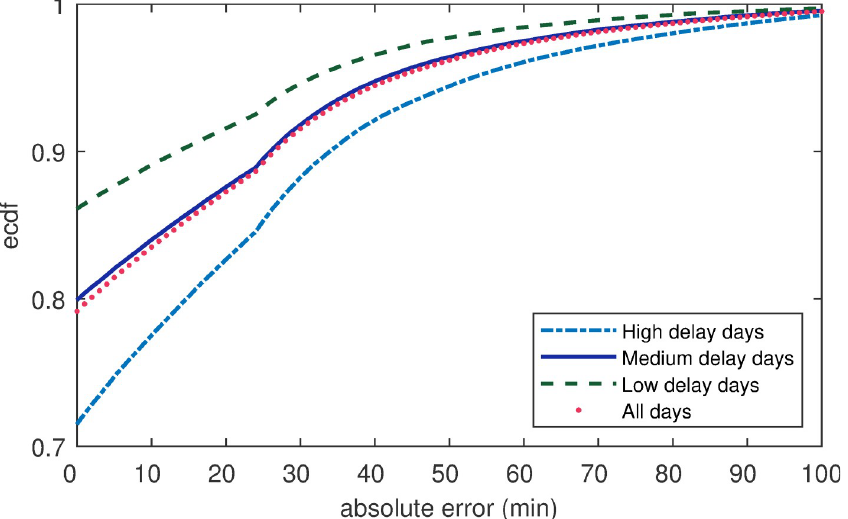
Fig 7. The empirical cumulative distribution function (ecdf) of the absolute errors of flight delays.